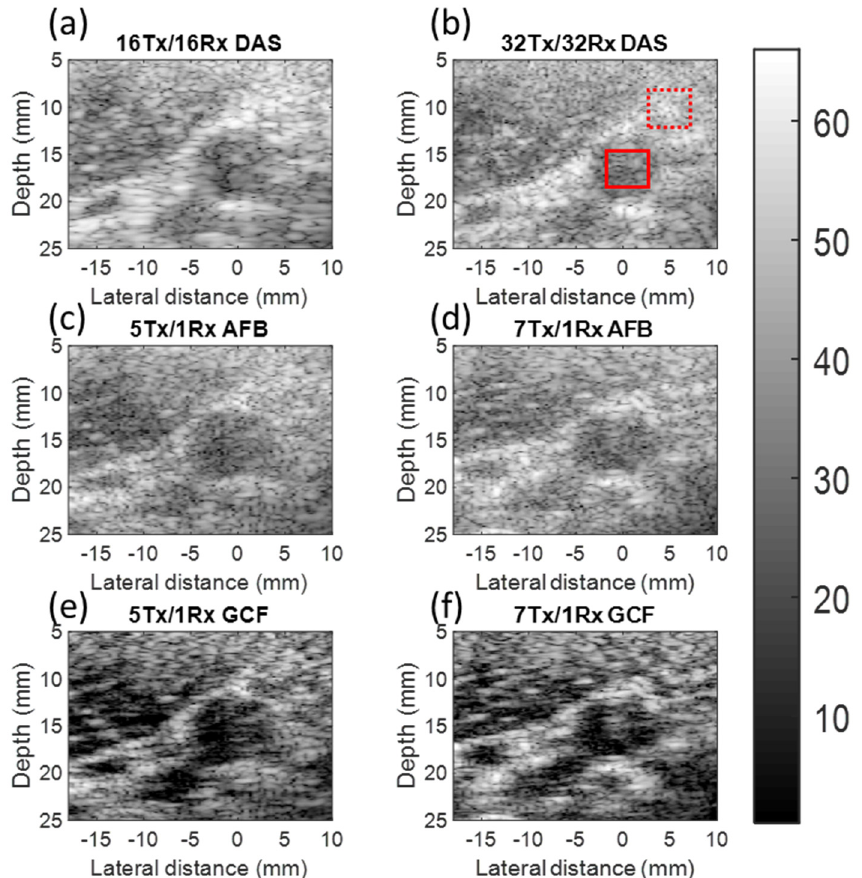
Figure 8. Carotid artery in vivo results. ( a ) 16 Tx/16 Rx DAS. ( b ) 32 Tx/32 Rx DAS. ( c ) 5 Tx/1 Rx AFB. ( d ) 7 Tx/1 Rx AFB. ( e ) 5 Tx/1 Rx GCF. ( f ) 7 Tx/1 Rx Table 4. Contrast (CR), standard deviation (STD), and contrast-to-noise ratio (CNR) of the images acquired using six methods, as shown in Figure 8.